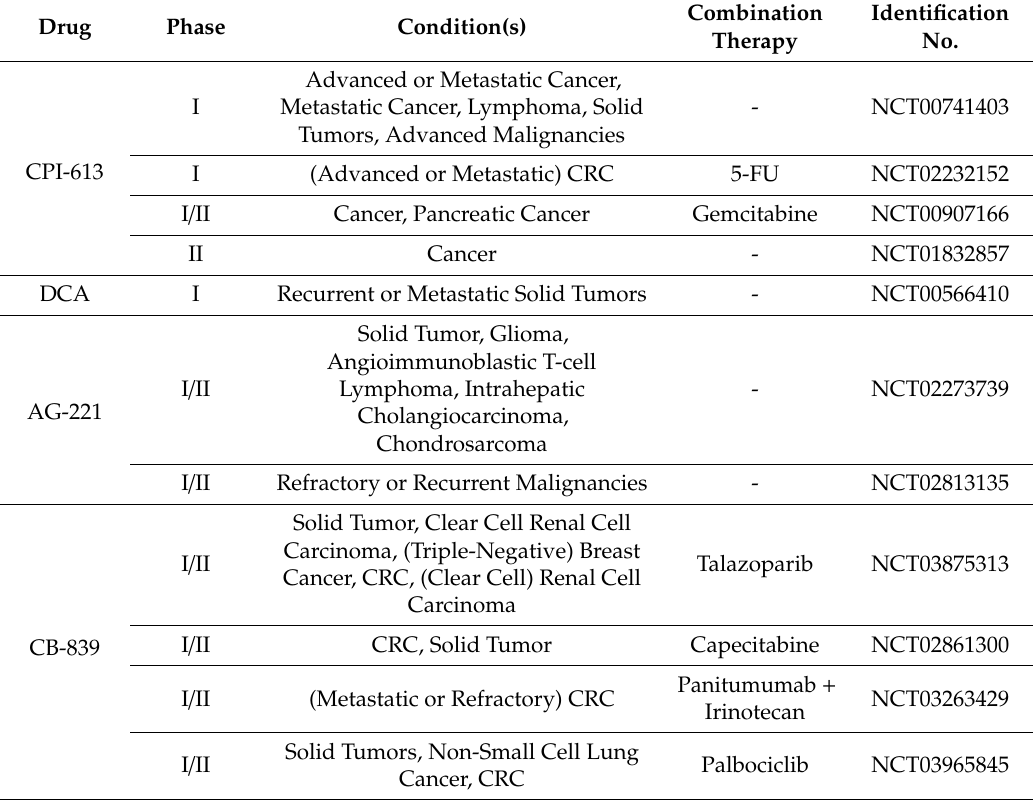
Table 1. Selected clinical trials for solid tumors including the colorectal cancer (CRC) of small molecules that target the TCA